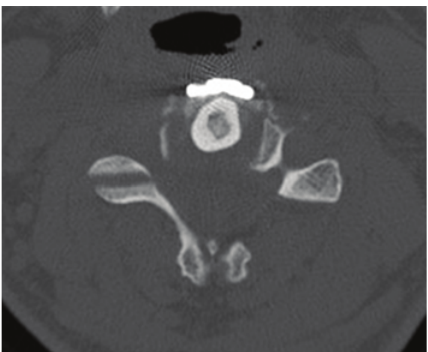
Figure 2: Axial CT scan demonstrating fibula strut graft placed in central corpectomy